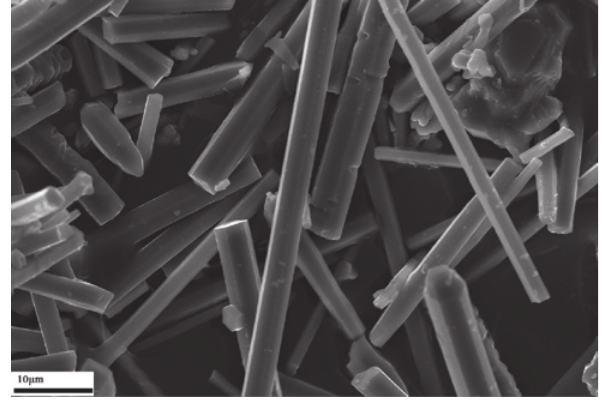
Fig. 6: SEM image of AlN whiskers with smooth